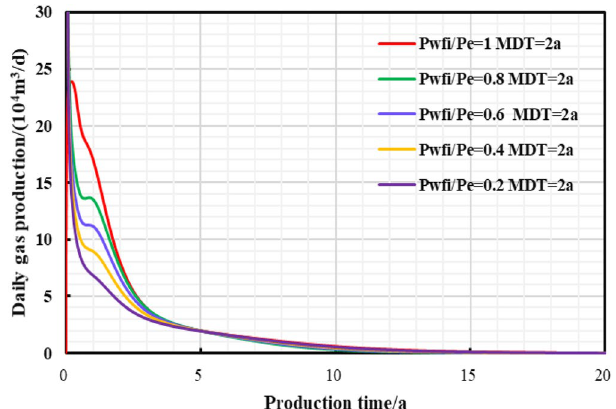
Figure 27. Daily gas production and time chart under different initial controlled pressures.